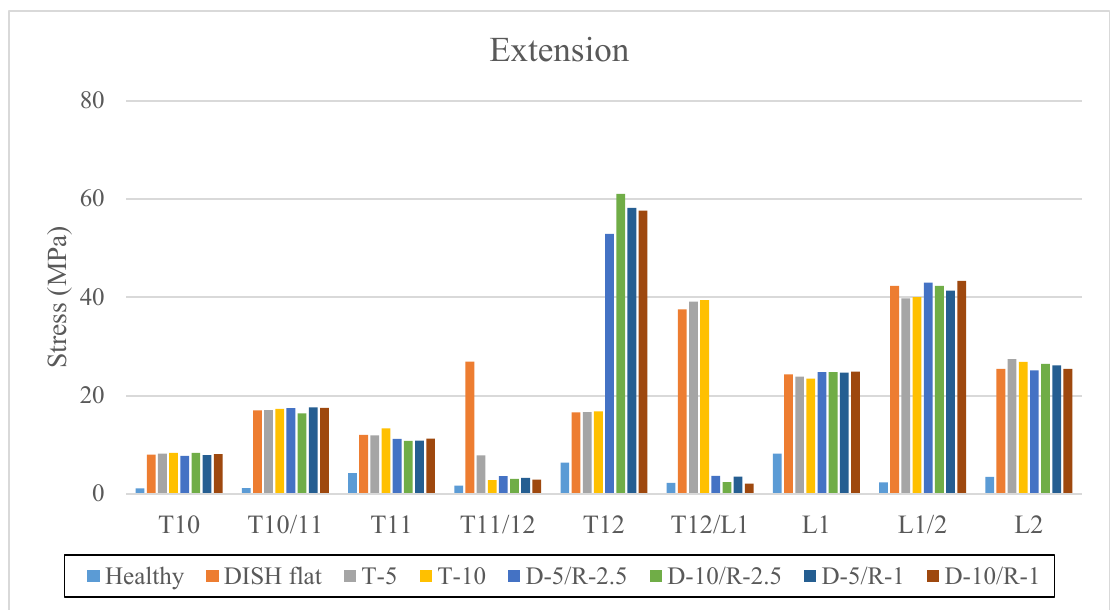
Figure 5. The highest value for maximum von Mises stress on the vertebral body and intervertebral disc (MPa) in extension. The vertical axis is stress (MPa), and the horizontal axis is each vertebral body and intervertebral level.